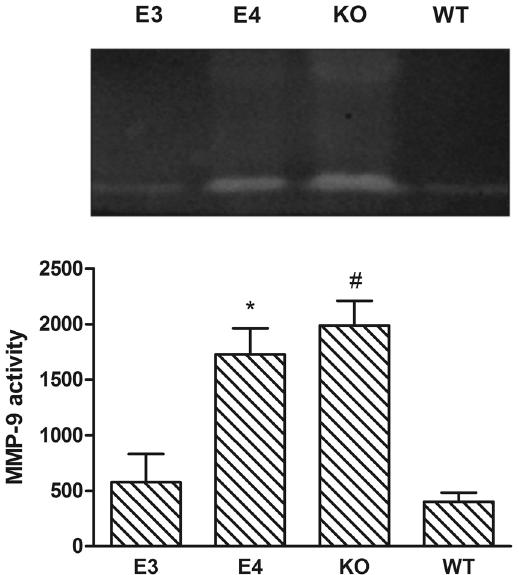
Figure 5. MMP-9 activity was detected at day 7 after injury and was significantly higher in the E4 mice compared with the E3 mice and the WT mice. More activity was found in the KO mice than in the WT mice. ( * P < 0.01 vs E3 and P < 0.001 vs WT mice; # P < 0.001 vs WT mice. N = 8). The data are presented as the mean ± SD.